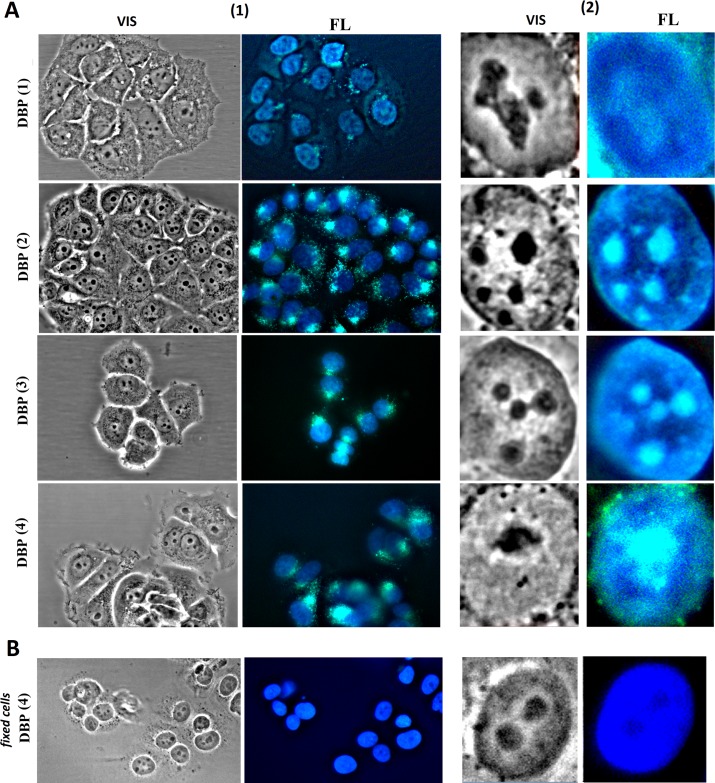
(A) DBP(1–4) localization in MCF-7 cells (1) and cell nuclei only (2). VIS—the photo of control cells in visible light; FL—λex = 380 nm. (1) Magnification X60. (2) For nuclei analysis the image size was increased by an order by computer processing. (B) MCF-7 were fixed with 3% PFA and treated with 0.1% triton X100 solution.